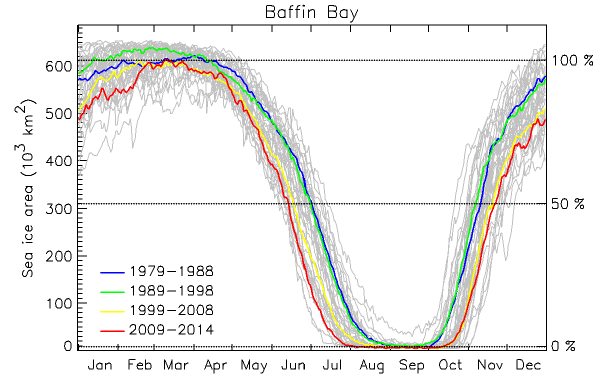
Figure 2. Daily sea-ice area in Baffin Bay (all depths), January– December, 1979–2014 (gray curves). The colored curves are decadal averages, as indicated in the legend. The upper horizontal dotted line (at 613 × 10 3 km 2 ) is the average sea-ice area in March (1979–2014); the lower horizontal dotted line (at 9 × 10 3 km 2 ) is the average sea-ice area in September. The middle horizontal dotted line, halfway between the upper and lower lines, is the threshold for determining the spring and fall transition dates in Baffin Bay. See Fig. S1 for similar plots for other subpopulation regions.